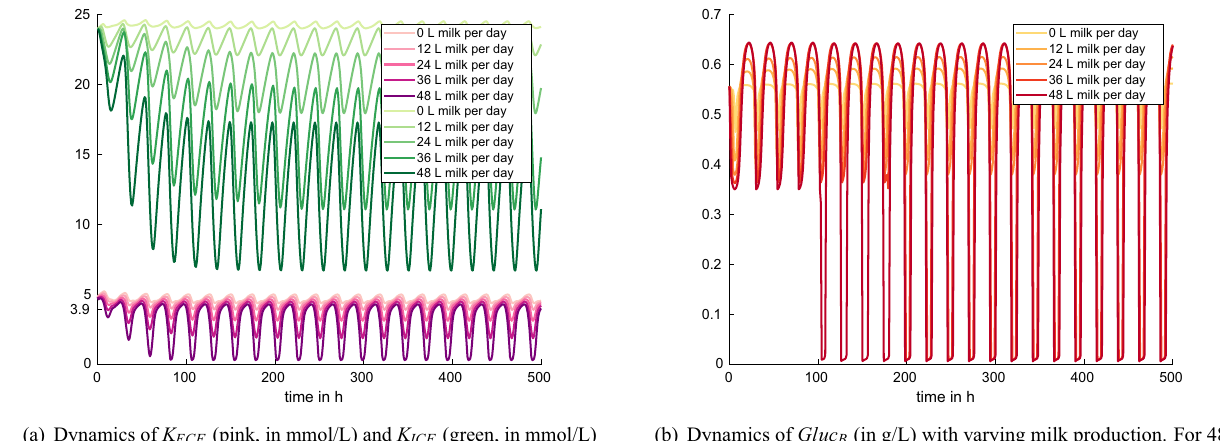
(a) Dynamics of the component K ECF (in mmol/L) and K ICF (in mmol/L) under varying pH . K ICF (green) decreases with decreasing pH mean, but there is no change in K ECF dynamics (violet). Figure 6. Experiment 5: variations in the mean pH value (default model